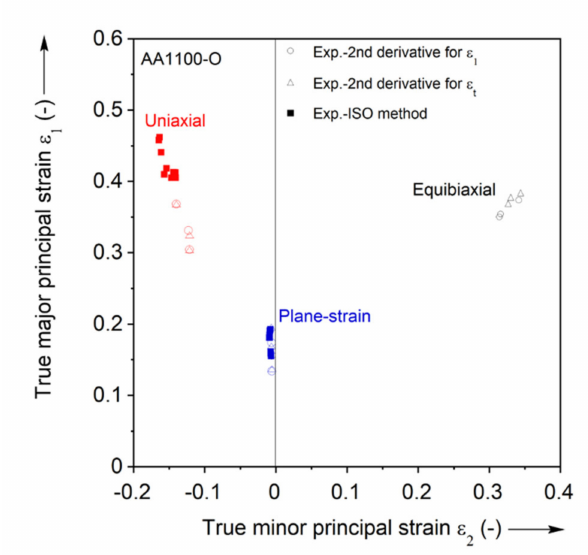
Figure 18. FLC points identified by second derivative and ISO methods and